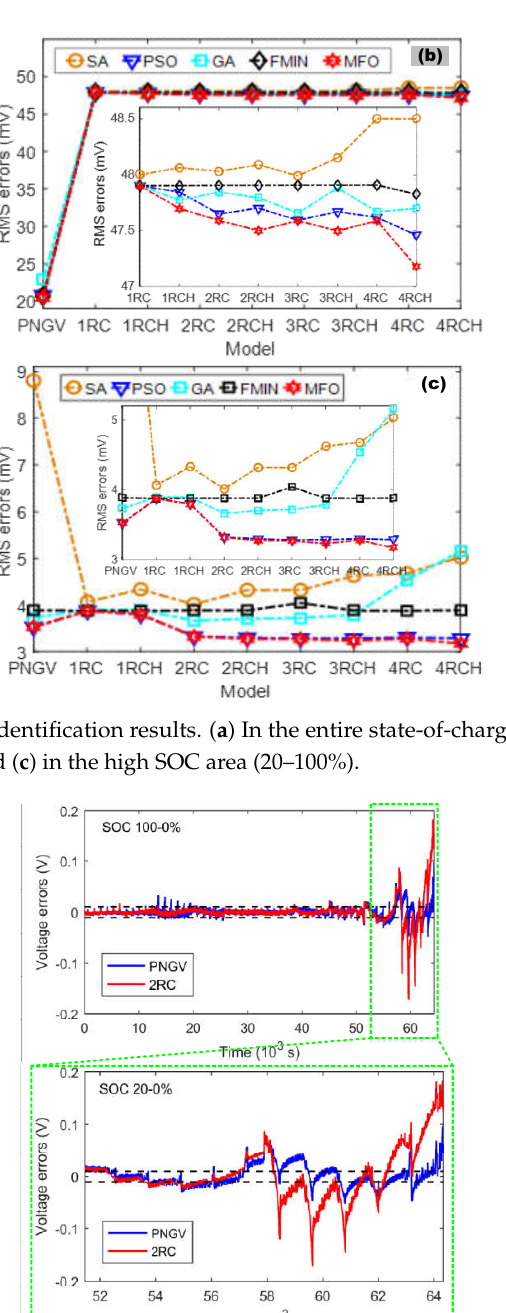
Figure 5. The error distribution comparison between the PNGV model and the 2RC model. Appl. Sci. 2018 , 8 , 2028